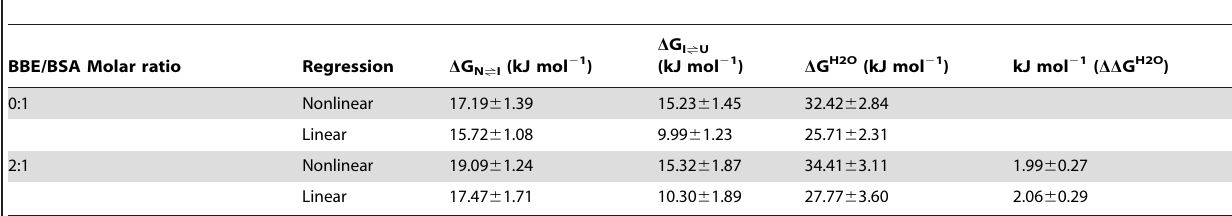
Table 3. The effect of 1,2- Bis (2-Benzimidazolyl) 1,2-Ethanediol binding on unfolding transition of BSA.